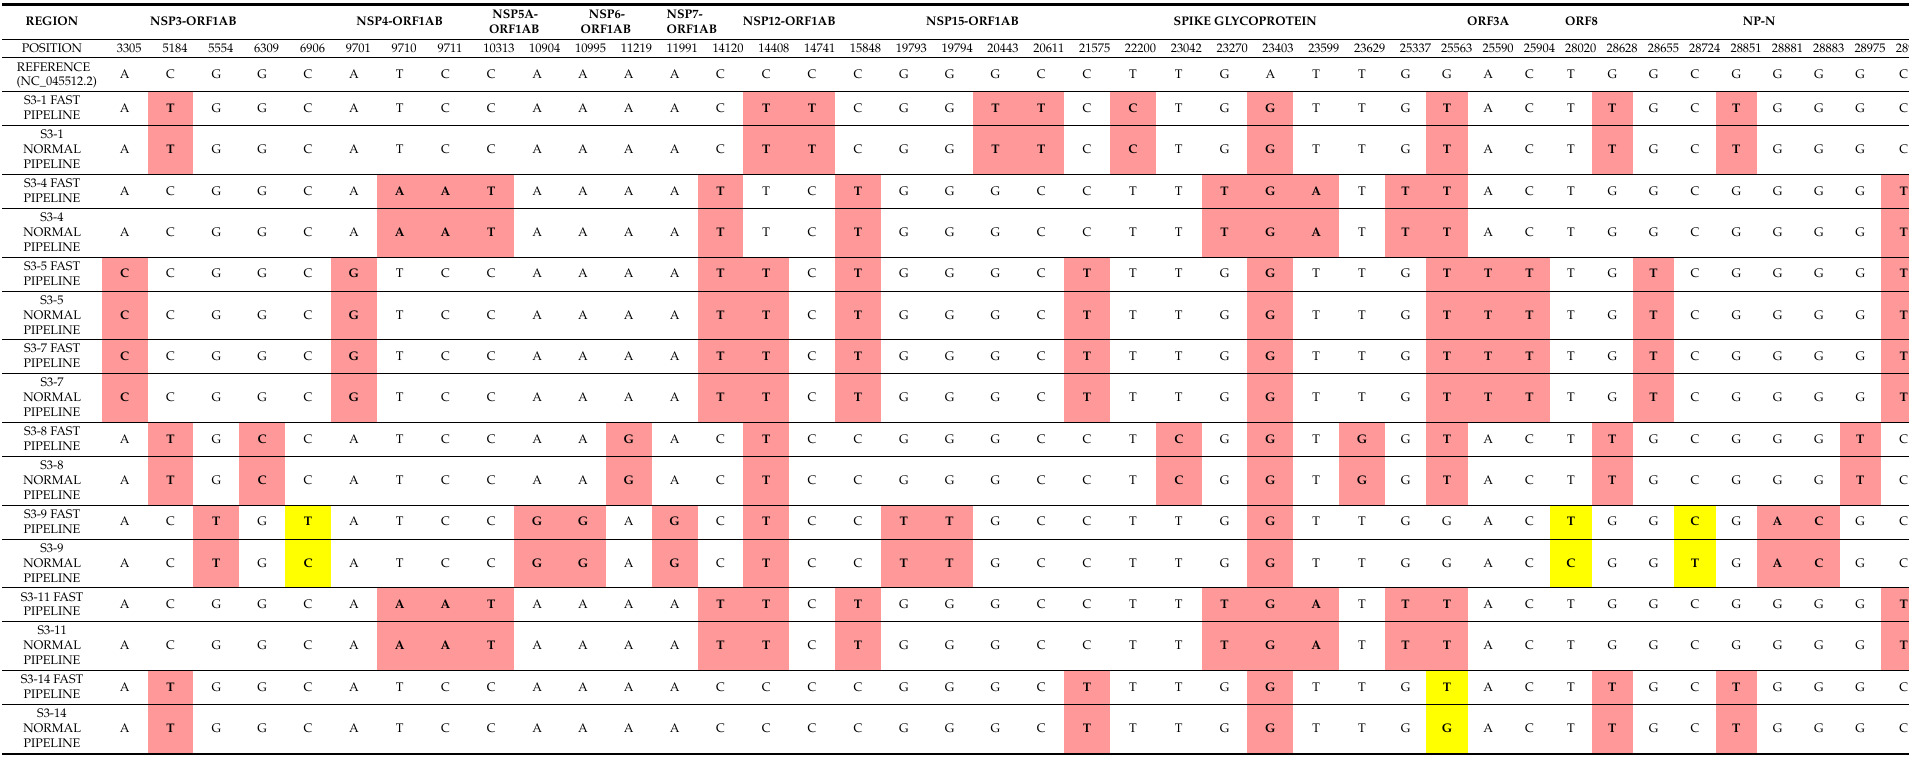
Table 10. Identified SNPs in All Batch 3 Samples Running All